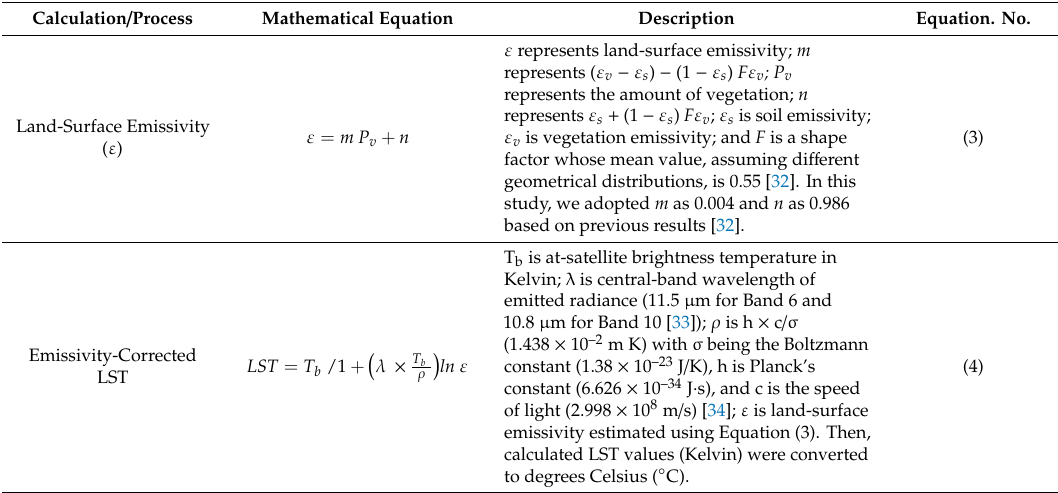
Table 3. Description of land-use / land-cover (LULC) classes with respective codes and image references. LULC Code Description Image Reference * Impervious surface IS Forest cover FC